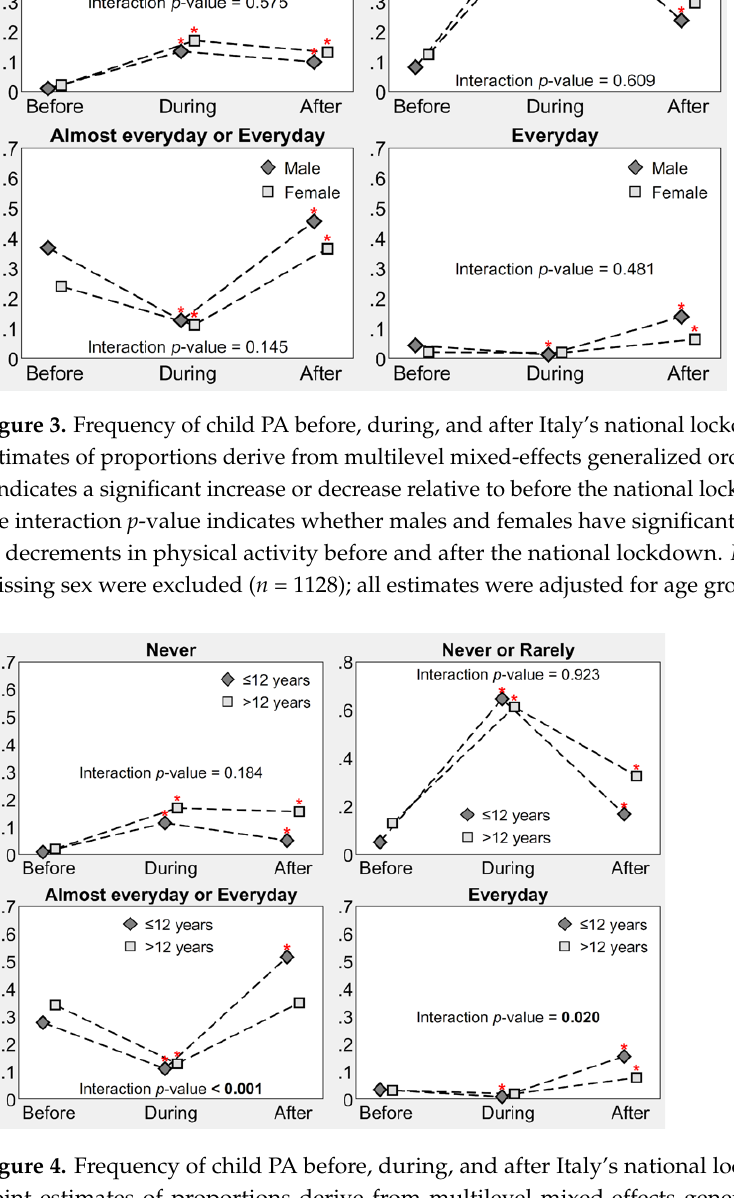
Figure 4. Frequency of child PA before, during, and after Italy’s national lockdown, by age group. Point estimates of proportions derive from multilevel mixed-effects generalized ordered probit regression; * indicates a significant increase or decrease relative to before the national lockdown ( p -value ≤ 0.05); the interaction p -value indicates whether ≤ 12- and >12-year olds have significantly different increments or decrements in physical activity before and after the national lockdown. Note: All estimates were adjusted for